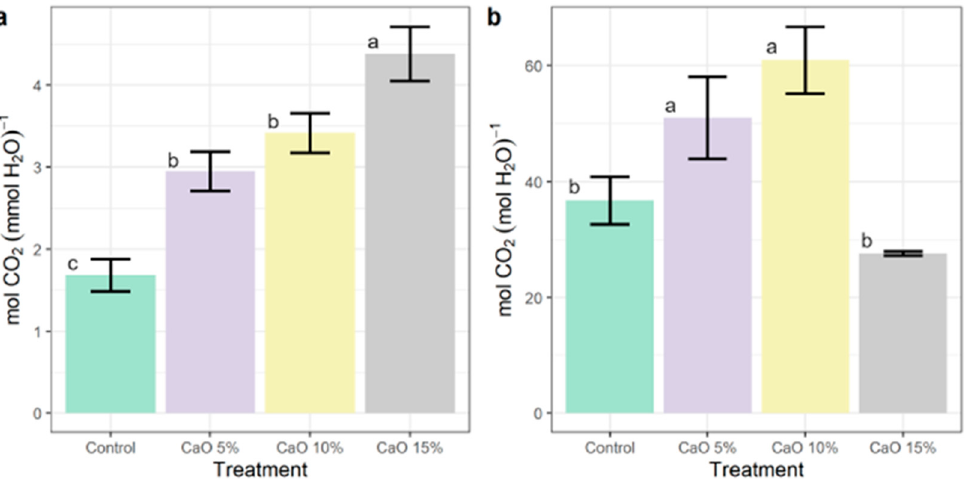
Figure 4. ( a ) Instantaneous water use efficiency ( F = 74.21; df = 3, 9; p < 0.0001) and ( b ) intrinsic water use efficiency ( F = 37.32; df = 3, 9; p < 0.0001) of sweet potato ( Ipomoea batatas L.) plants sprayed with calcium oxide (CaO) particle films at 5, 10, and 15% w / v and control (water). Values represent mean (±standard deviation), and bars followed by the same letter did not differ according to the Tukey test ( p < 0.05) ( n = 4).